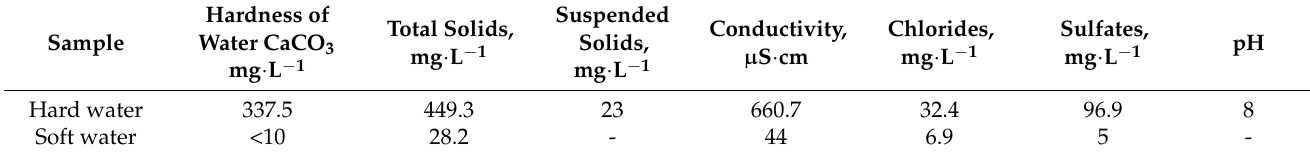
Figure 1. Scheme of experimental system and its components. Table 1. Hardness analysis of the water used in air-mists.